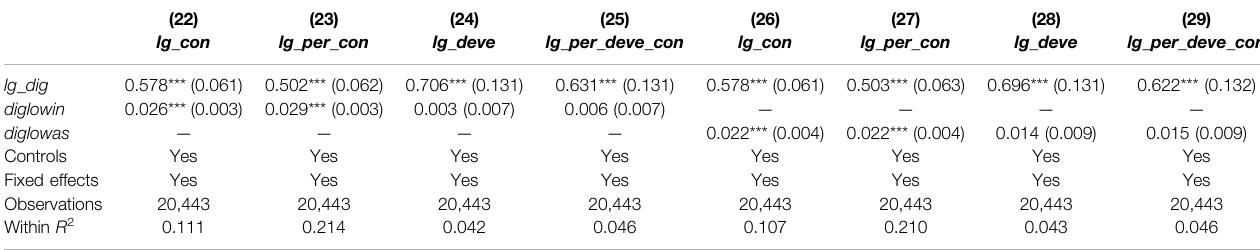
TABLE 6 | Heterogeneous analysis: rural households of different incomes and assets.